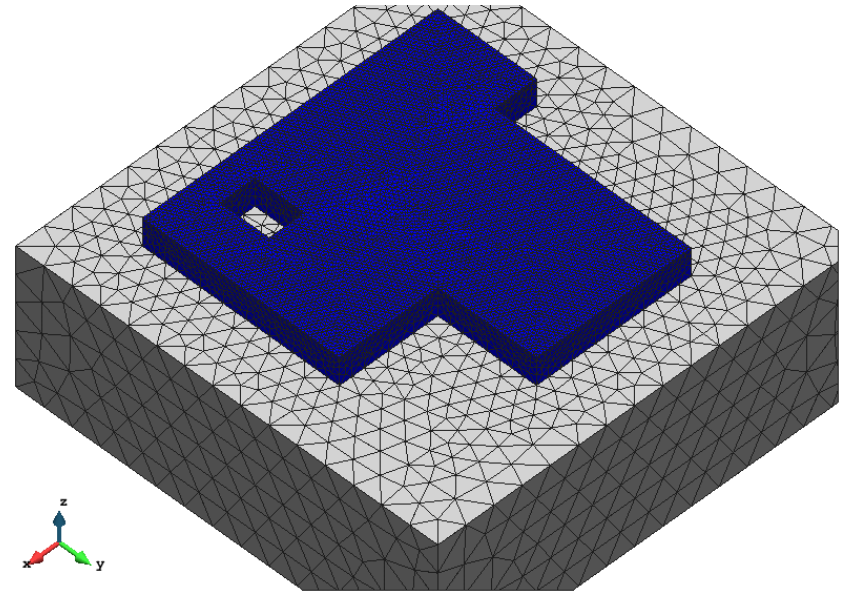
Figure 3. Geometric characteristics and finite element mesh of the simulated foundation.